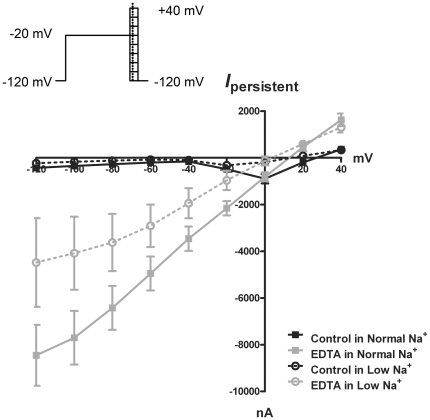
The IDF is a Na+-permeable non-selective cation current.Mean ± S.E.M. Vagal neurons were held at −120 mV, prepulsed to −20 mV for 200 ms and then stepped from −120 to +40 mV in 20 mV increments for 25 ms (current measured at 1 ms). The current-voltage relationship from this NaV inactivation protocol is shown for cells bathed in “Normal Na+” 154 mM NaCl-containing solutions: control external solution (solid line, black squares) and solution containing 5 mM EDTA (0 Ca2+, 0 Mg2+) (solid line, grey squares; n = 15). Also depicted are the current-voltage relationships for cells bathed in “low” 100 mM NaCl-containing solutions: control external solution (dotted line, empty black circles) and solution containing 5 mM EDTA (0 Ca2+, 0 Mg2+; dotted line, empty grey circles; n = 6).